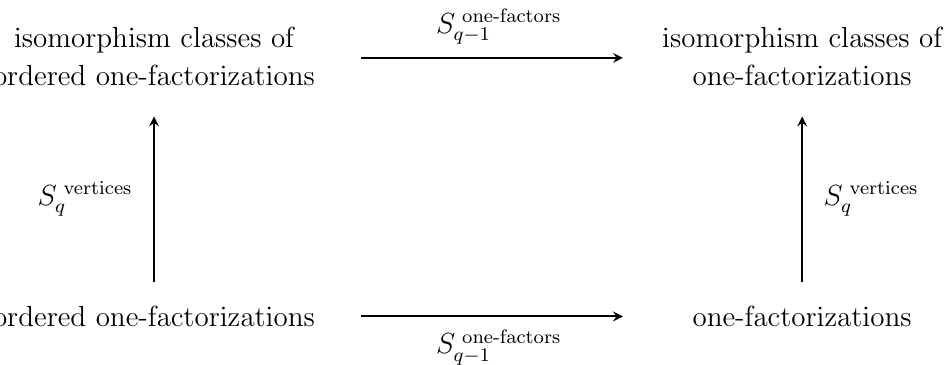
Figure 12. The relationship between ordered one-factorizations, one-factorizations, and their